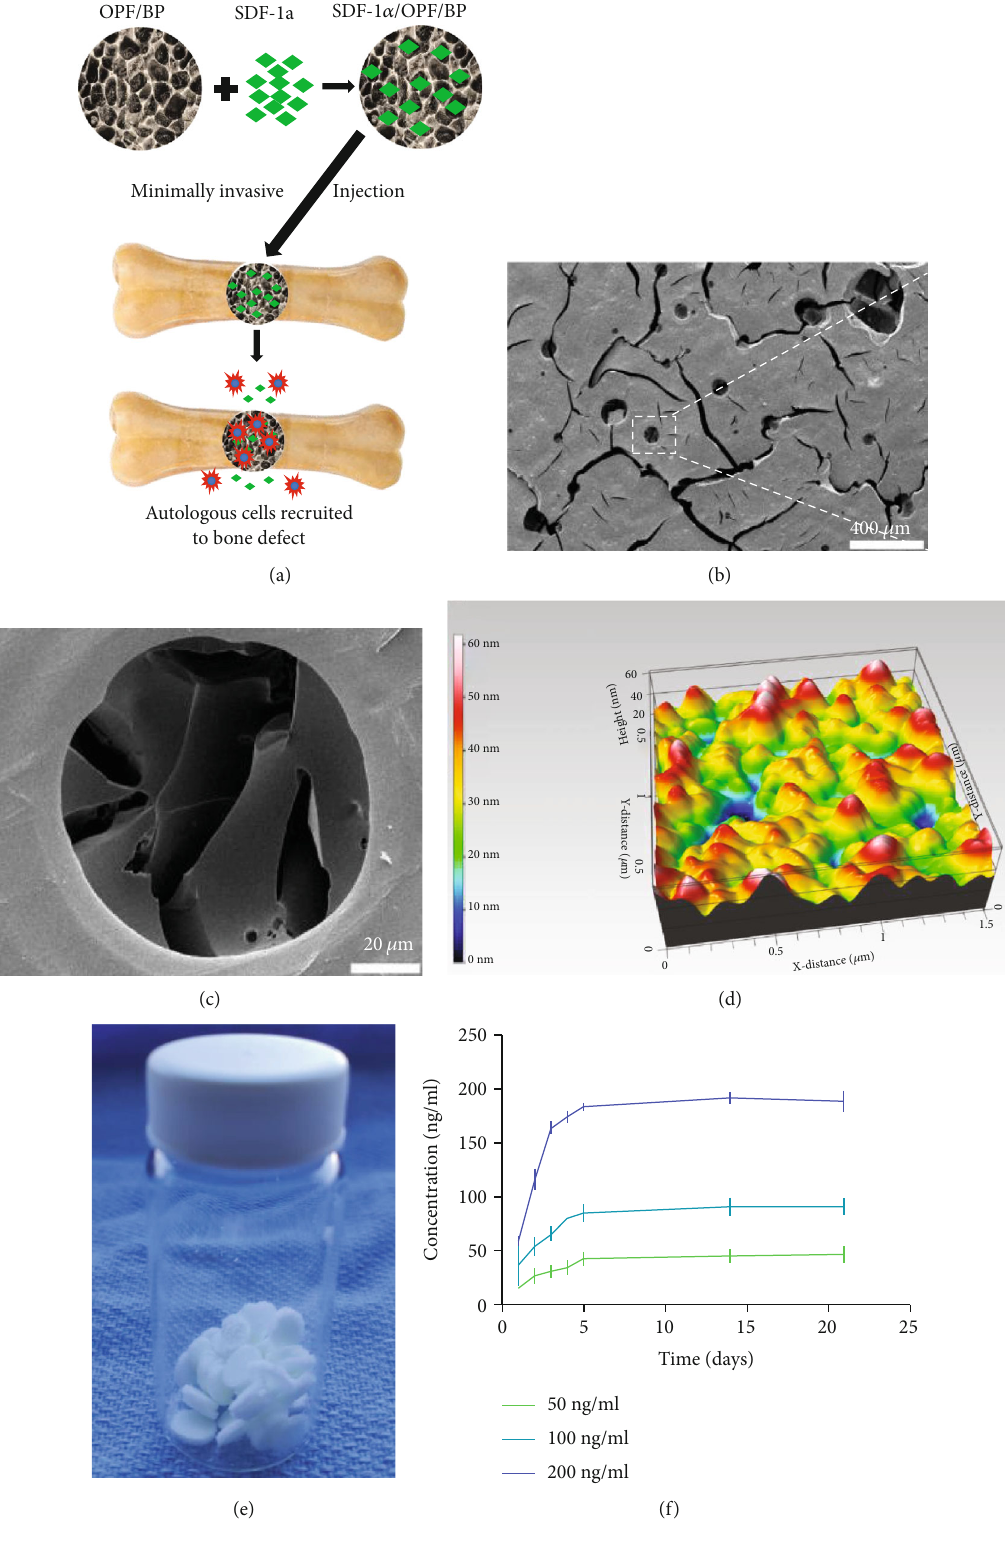
Figure 2: (a) Schematic illustration of the construction of SDF-1 α /OPF/BP composites for the repair of the bone defect. (b, c) SEM images of OPF/BP hydrogel. (d) AFM image of OPF/BP hydrogel. (e) Photograph of OPF/BP hydrogel discs. (f) Release pro fi les of SDF-1 α /OPF/BP composites showed the concentrations of SDF-1 α in the culture medium. The release curve showed all groups reached 80% release percentage on the 4th